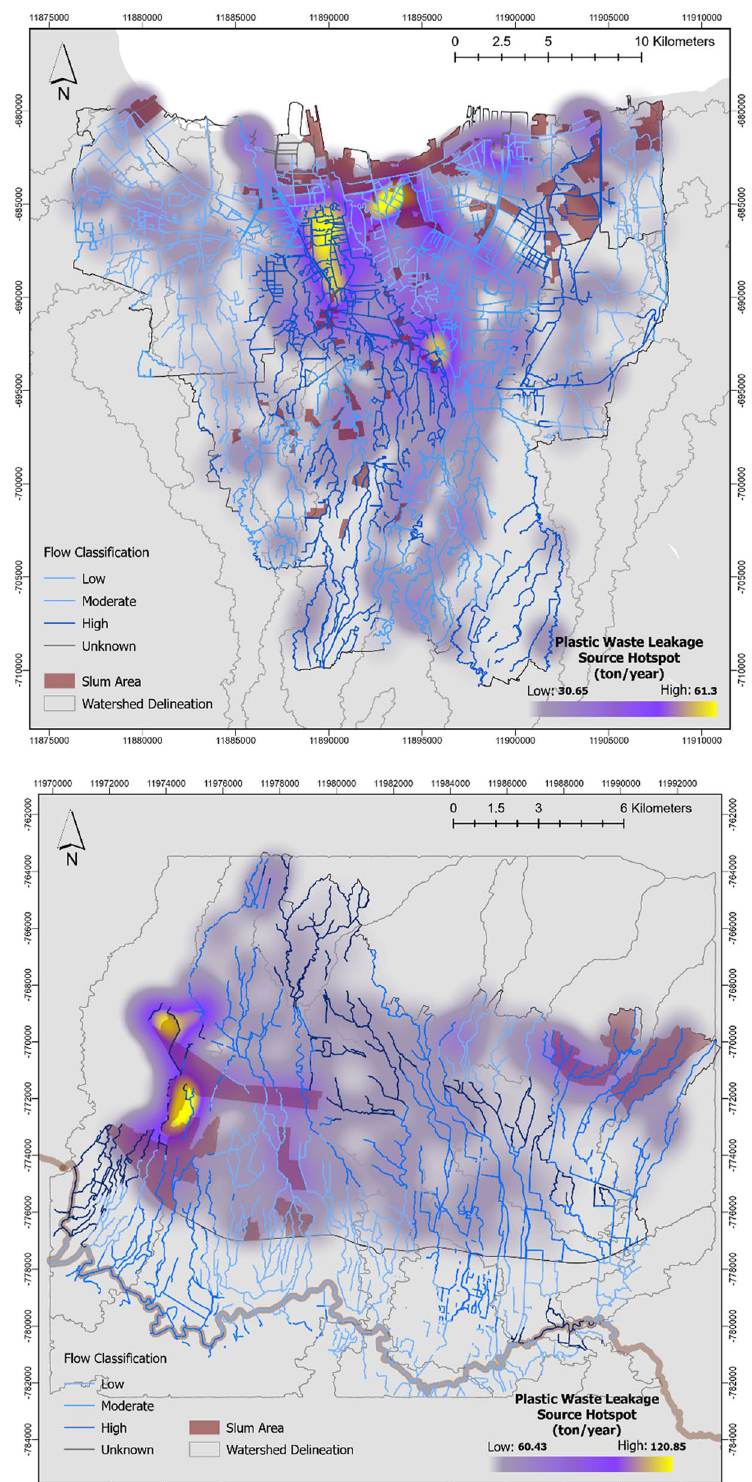
Figure 3. Plastic leakage pathway model in (top) DKI Jakarta and (bottom) Bandung City based on the hotpot from treatment